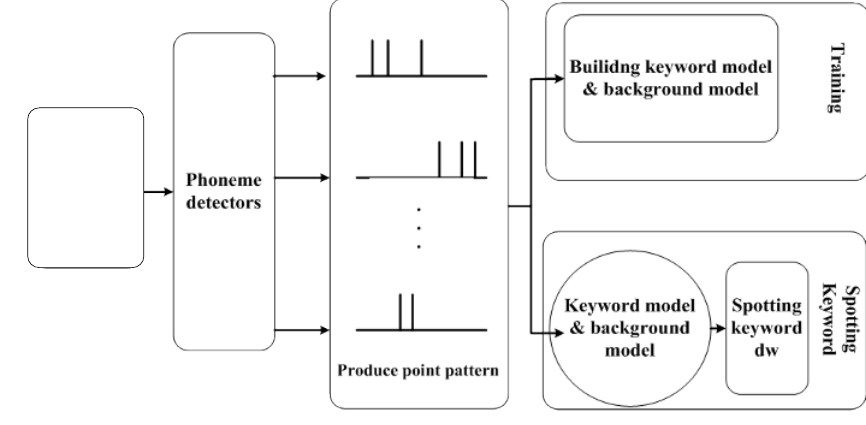
Fig. 3. Framework of point process keyword spotting system